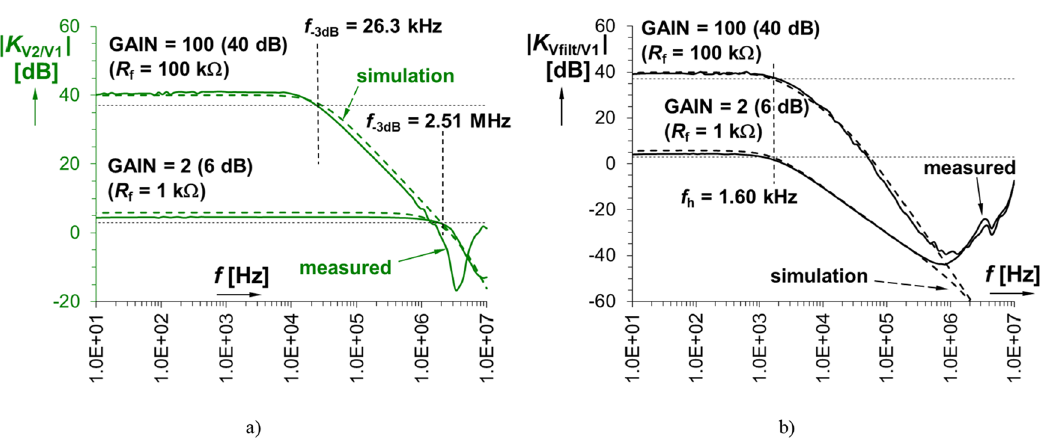
Figure 3. The magnitude frequency response (transfer) of the linear part: ( a ) input amplifier, ( b ) amplifier and filter